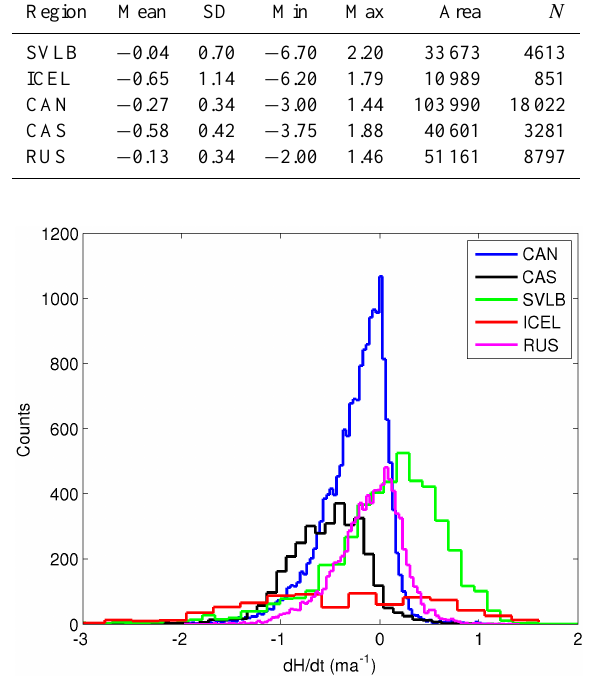
Figure 2. Histogram of elevation changes for the different Arctic regions. The Russian High Arctic (RUS) is treated as one region for visualization